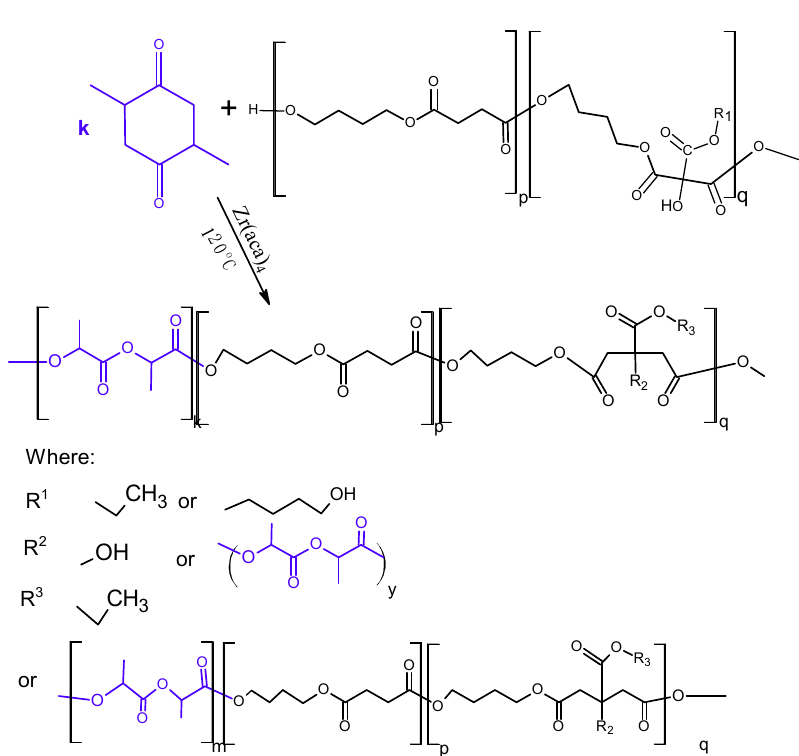
Scheme 2. Polymerization of l -lactide using polyesters as a macroinitiator. Table 2. Properties of obtained poly( L -lactide)– block –poly(butylene succinate copolymers. Sample